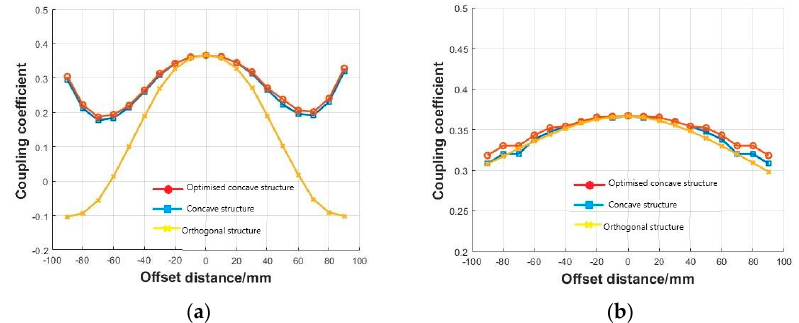
Figure 13. ( a ) Variation of coupling coefficients for offset in the X − axis direction. ( b ) Variation of coupling coefficients for offset in the Y − axis direction.